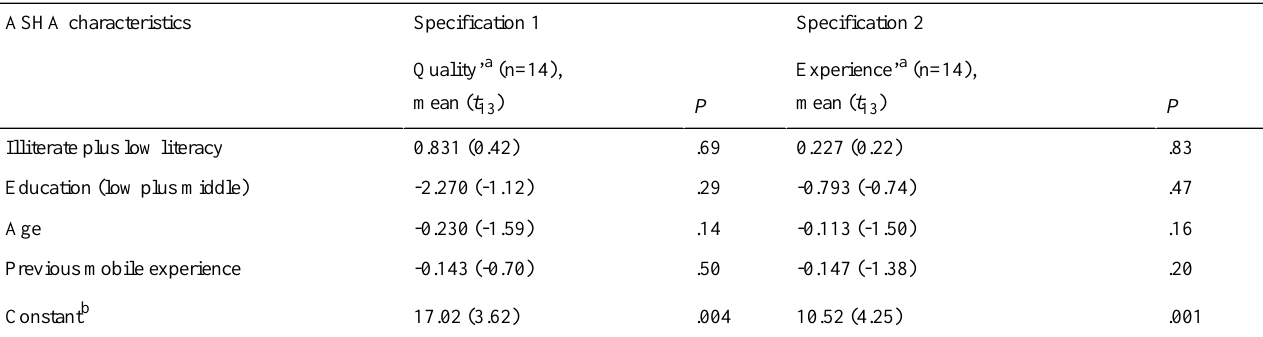
Table 13. The effect of ASHA characteristics on the relationship between CommCare user type and quality/experience of